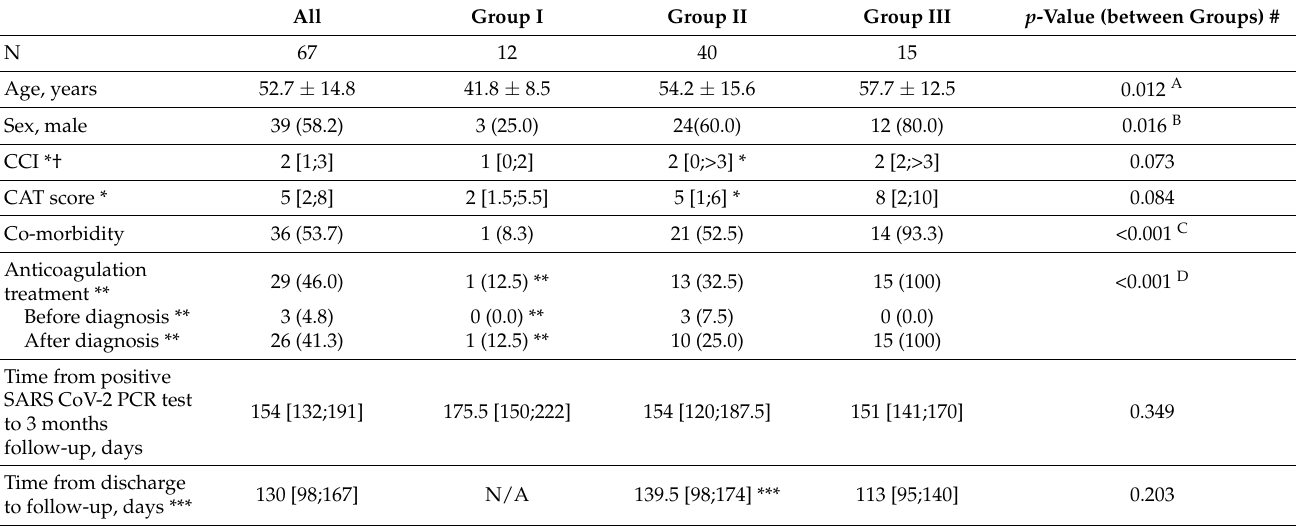
Table 1. Characteristic of patients with COVID-19 (n = 67) and difference between patients who were not hospitalised, hospitalised without ICU and with ICU